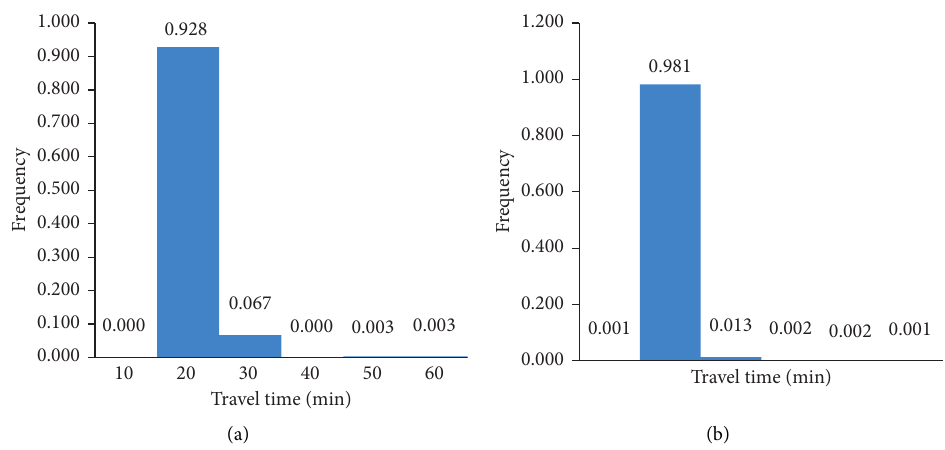
Figure 6: Frequency of travel times. (a) Dongzhimen to Dongdan. (b) Xizhimen to Xidan.